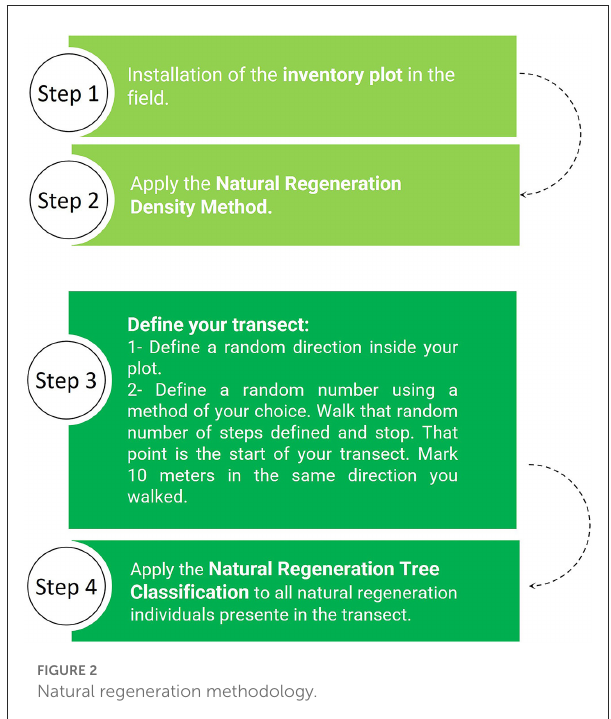
FIGURE2 Natural regeneration